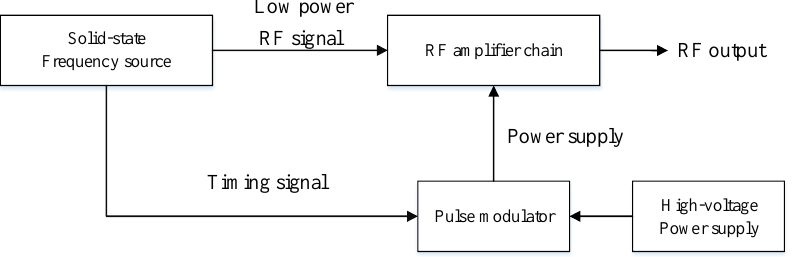
Figure 1. Composition of the MOPA transmitter, where the low-power RF signal is generated by the solid-state frequency source and amplified by the RF amplifier chain.